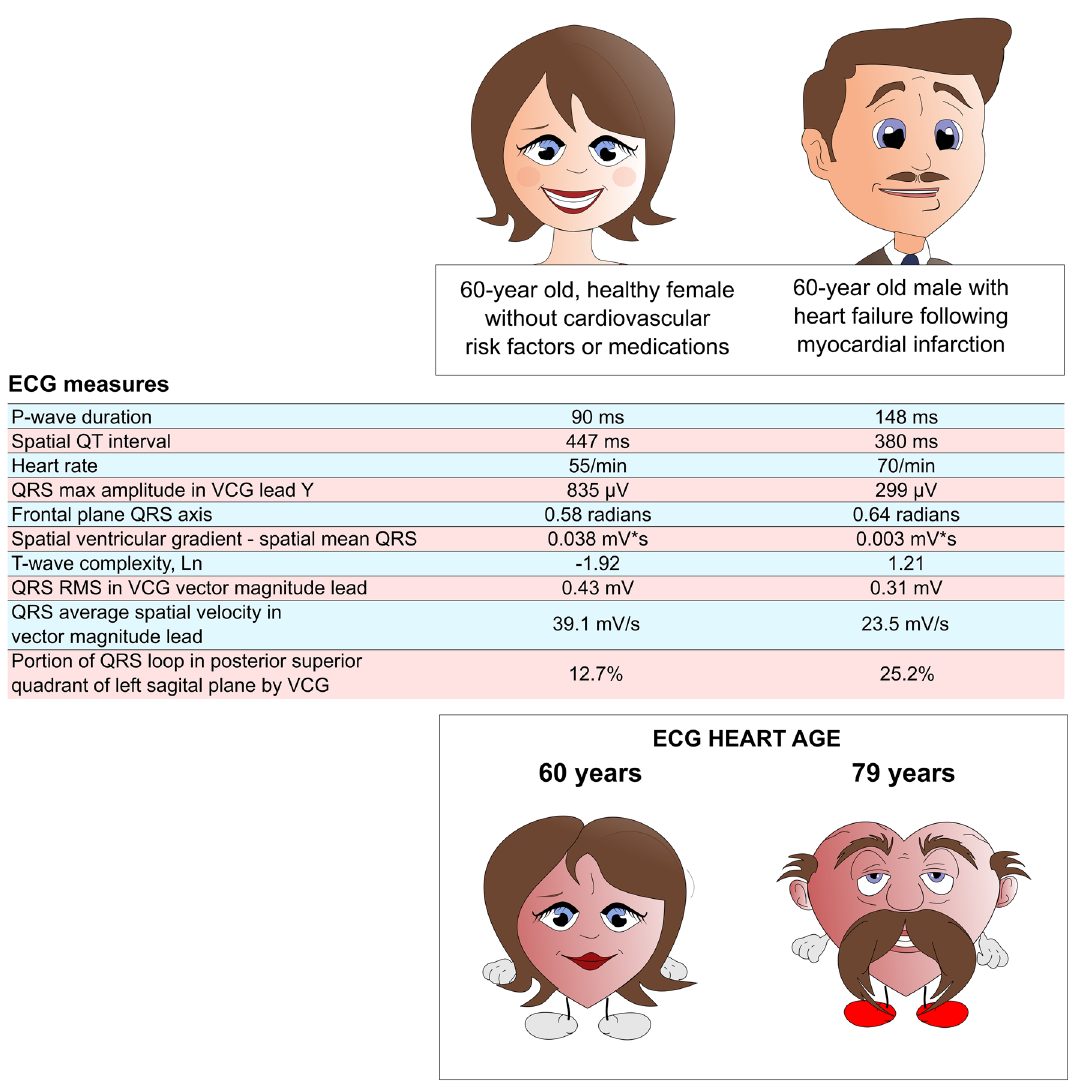
Figure 3. Example of the transparency and explainability of the Heart Age from two subjects with equal chronological age but different Heart Ages, illustrated by a commensurately aged female heart, but a disproportionately aged male heart. The ECG measures for each of the two patients are shown in the table in the middle of the figure, presented in the order of the relative strength (strongest first, based on t ratio [not shown]) of contribution to the Heart Age. Notably, P-wave duration is markedly different between these two patients, and heart rate is higher for the male than the female, helping drive the Heart Age higher in the male. The R-wave amplitude in lead Y is also much larger in the female, and the difference between the spatial ventricular gradient and the spatial mean QRS in the female is also larger, likely due to preserved T-wave amplitudes, contributing to her relatively younger Heart Age. Furthermore, possibly due to ischemic myocardial injuries, T-wave complexity is increased in the male, suggesting that increased myocardial repolarisation heterogeneity also contributes to driving Heart Age higher in the male, in spite of his shorter QT